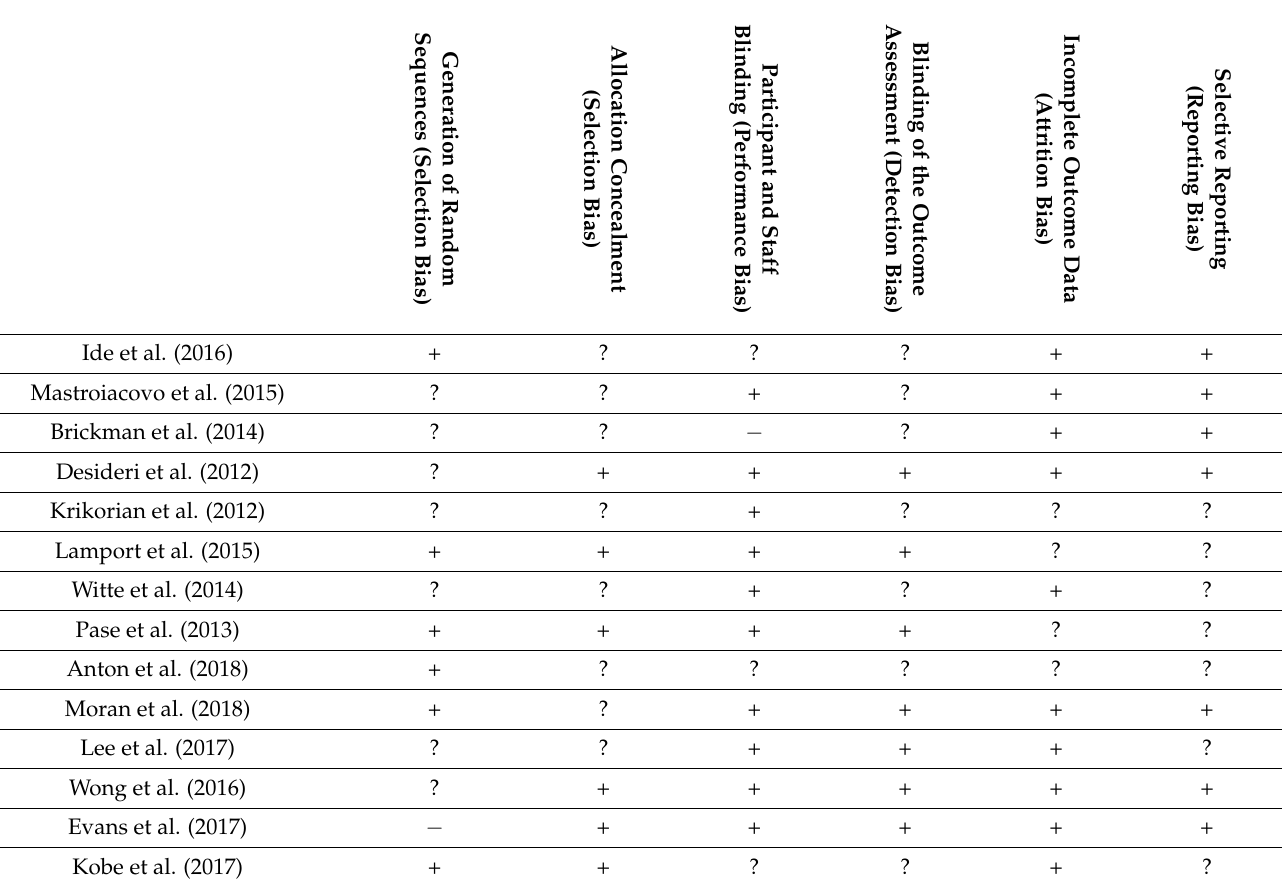
Table 4. Summary assessments of risk of bias of the studies included with the Cochrane Collabora- tion’s